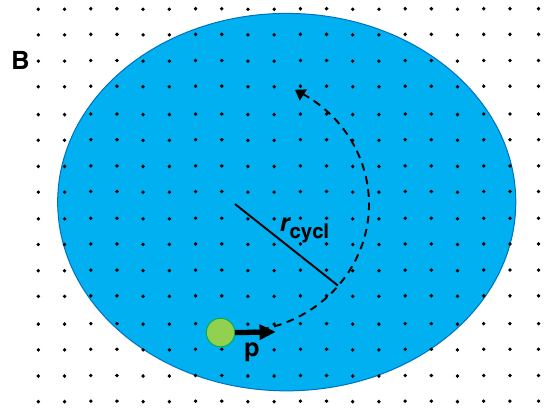
FIG. 1. Proposed experiment to measure the renormalized mass and the fractional charge of an anyonic molecule. An impurity atom (green circle) is located in the bulk of a fractional quantum Hall fluid of atoms (blue region). Its repulsive interactions with the atoms make it bind one or more FQH quasiholes, forming a composite anyonic molecule with renormalized mass M , frac- tional (synthetic) charge Q , and anyonic fractional statistics. To measure the renormalized mass and charge, one can impart a momentum kick p to a single such molecule initially at rest and follow the ensuing cyclotron